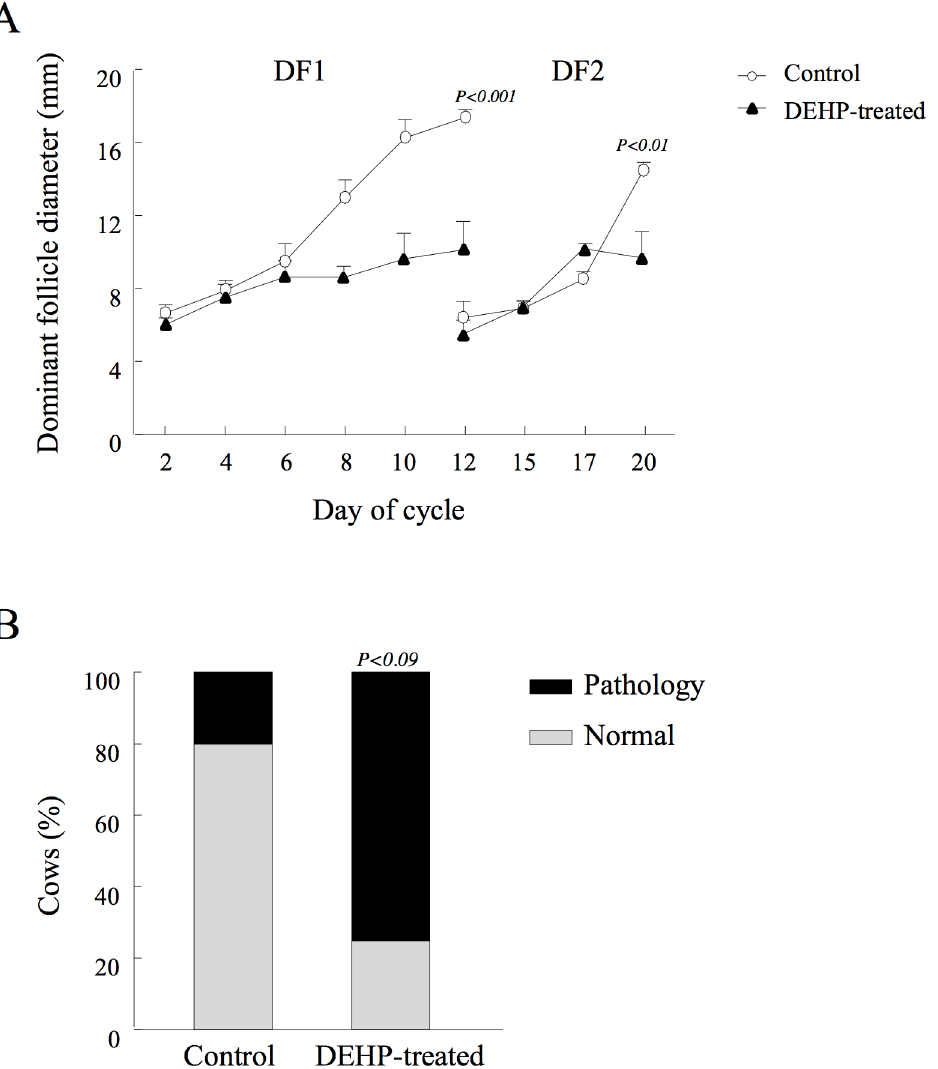
Fig 4. Effects of DEHP on diameter of first- and second-wave dominant follicles. Control and DEHP-treated cows were synchronized and ovarian follicular dynamics was monitored by linear ultrasonographic scanner throughout an entire cycle. The positon and diameter of the dominant follicles were recorded. (A) Mean diameters of first-wave dominant follicle (DF1) and second-wave dominant follicle (DF2). Data are presented as mean ± SEM; P -value indicates for treatment effect within experimental groups in each examined day. (B) Development of follicular pathologies, i.e., follicles with diameter > 25 mm and defined as able to develop to a persistent follicle or ovarian follicular cyst. Presented are the proportions of control and DEHP-treated cows with follicular pathologies, calculated out of total cows for each experimental group. P -value indicates for treatment effect within experimental